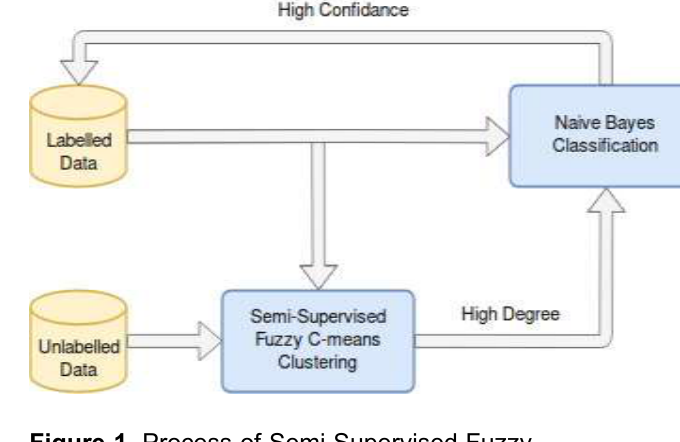
Figure 1. Process of Semi Supervised